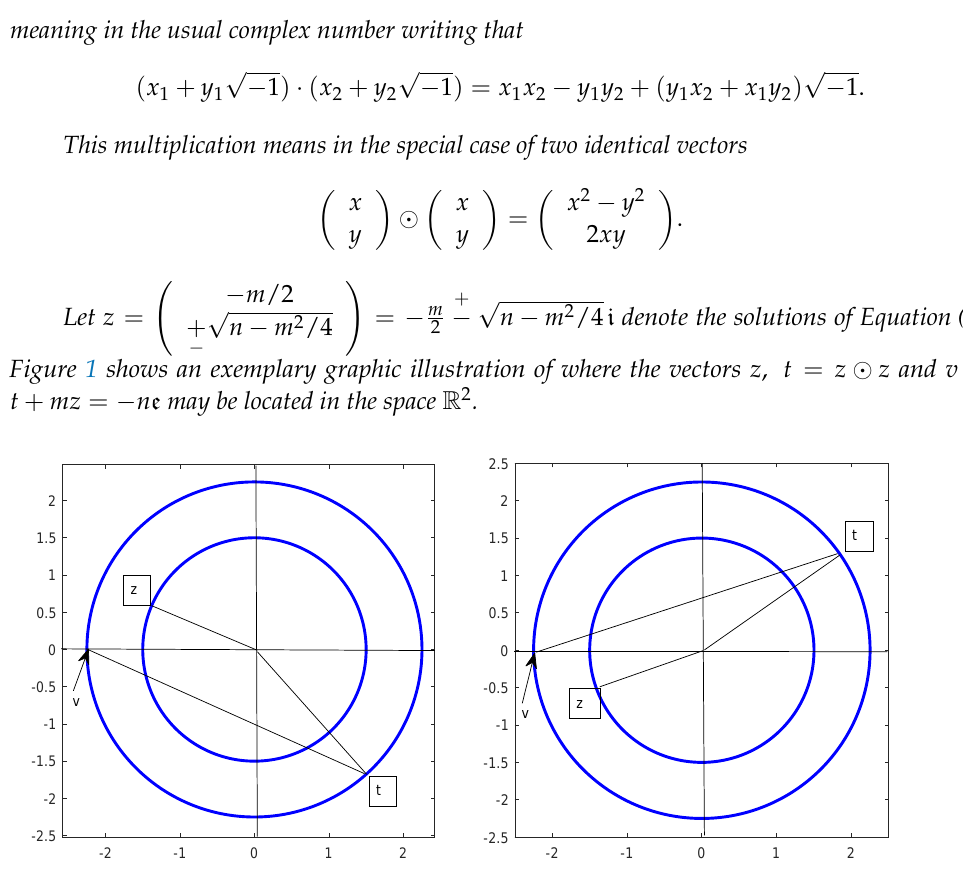
Figure 1. Geometry of quadratic equations with respect to standard vector multiplication. The √ n = 1.5 and n = 2.25, Euclidean circles have the radii